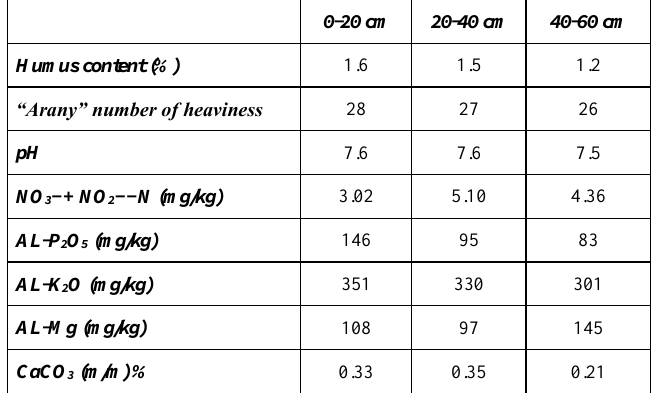
Table 1 . Soil parameters of the experimental sweet cherry orchard (Debrecen-Pallag, 2016).